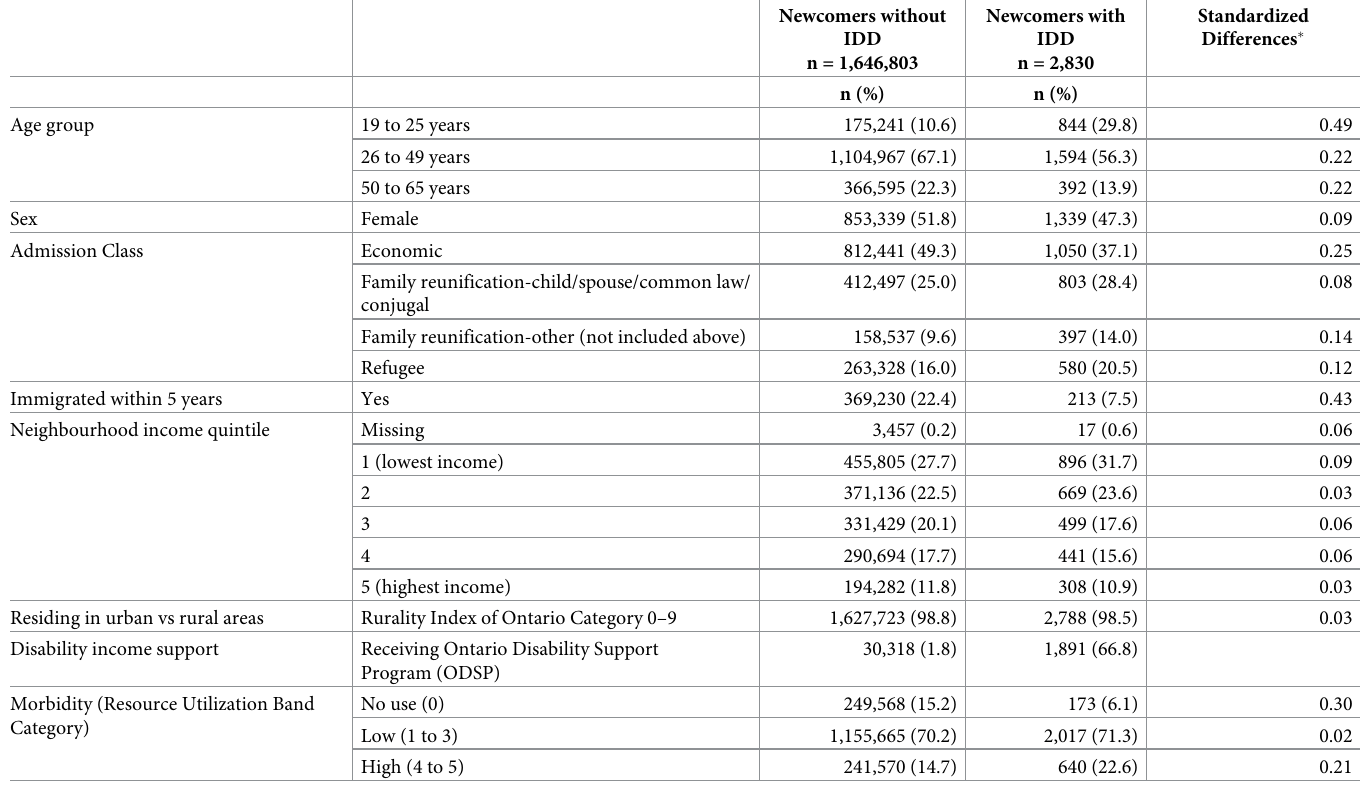
Table 2. Sociodemographic and immigration characteristics of newcomers with and without intellectual and developmental disabilities (IDD), for adults aged 19– 65 in Ontario, FY